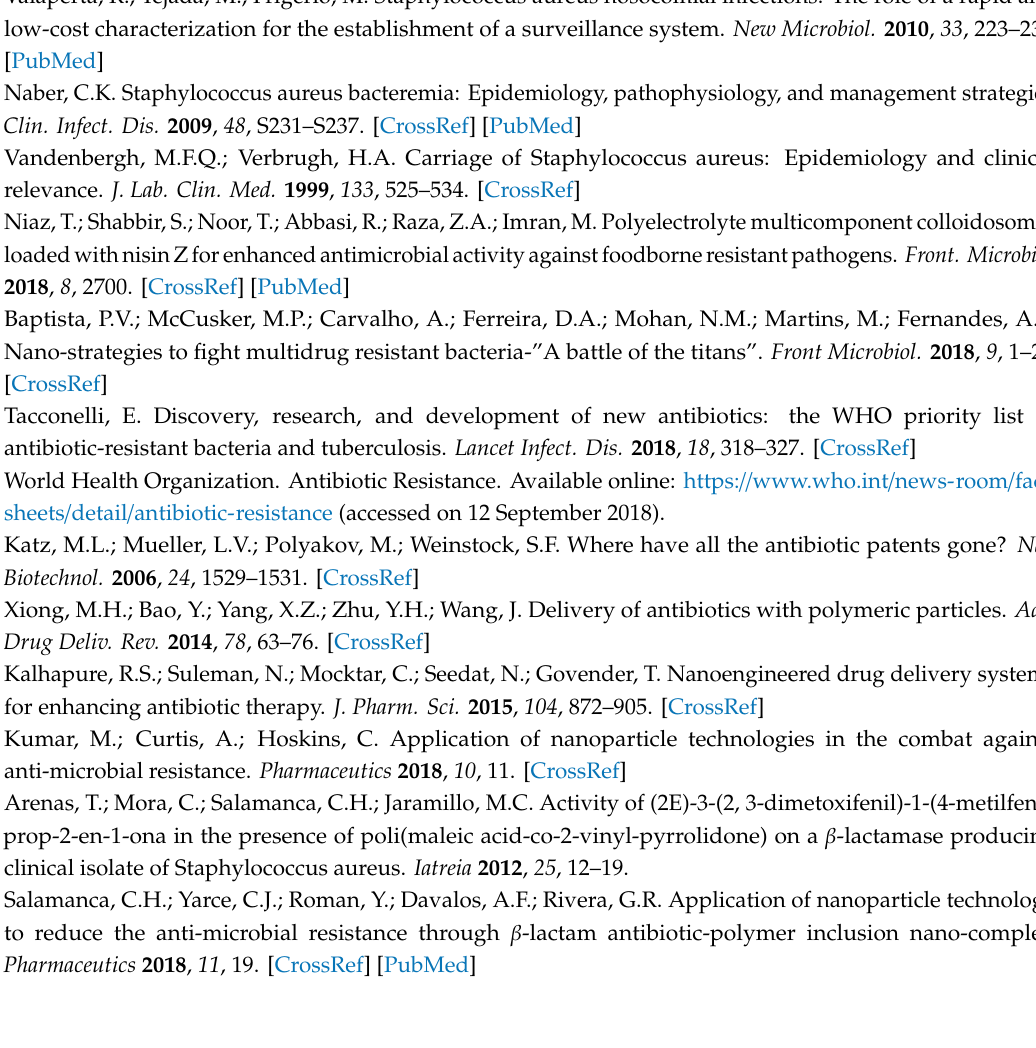
Figure S1: Infrared spectrum for commercial chitosan and alkali-processed chitosan with a degree of deceleration > 90% (chitosan